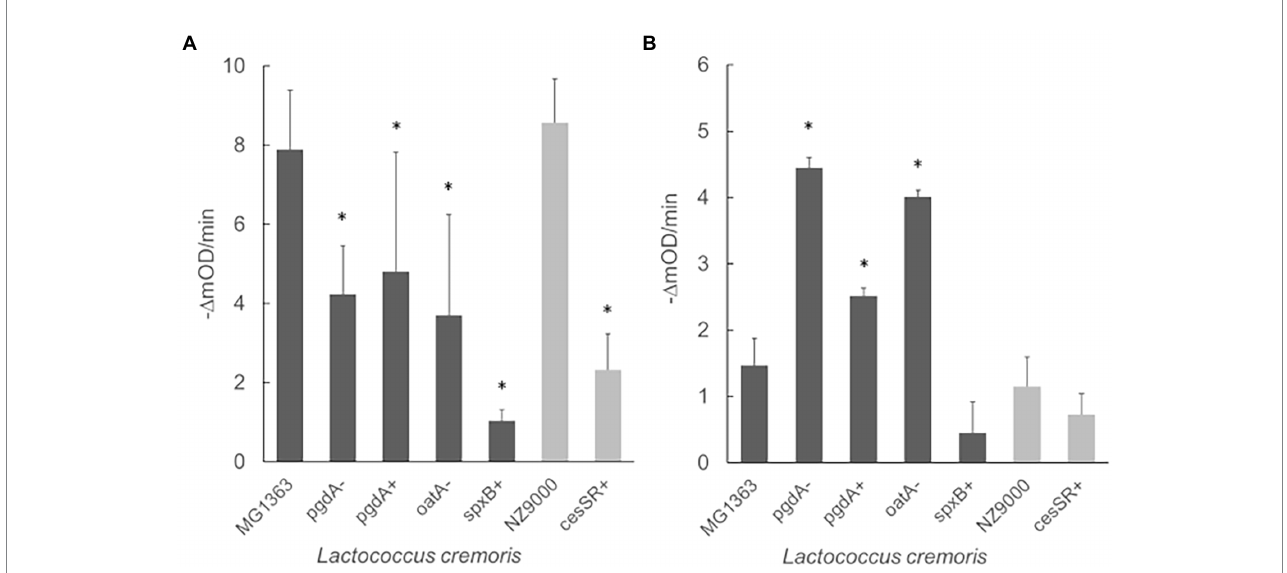
FIGURE 3 Exolytic activity of Lys1358 (A) and LysC2 (B) against CES and PG lactococcal mutants as determined by turbidity reduction assays. Purified Lys1358 (0.5 μ M) and LysC2 (4.5 μ M) were incubated with frozen cells and the decrease in OD 600 (expressed in mili OD units, mOD) was monitored (- Δ mOD/min). Dark grey columns: L. cremoris MG1363 and derived mutants. Light grey columns: L. cremoris NZ9000 and derived mutants. *, Significantly different ( p < 0.05) compared to the wild type L. cremoris MG1363 and NZ9000